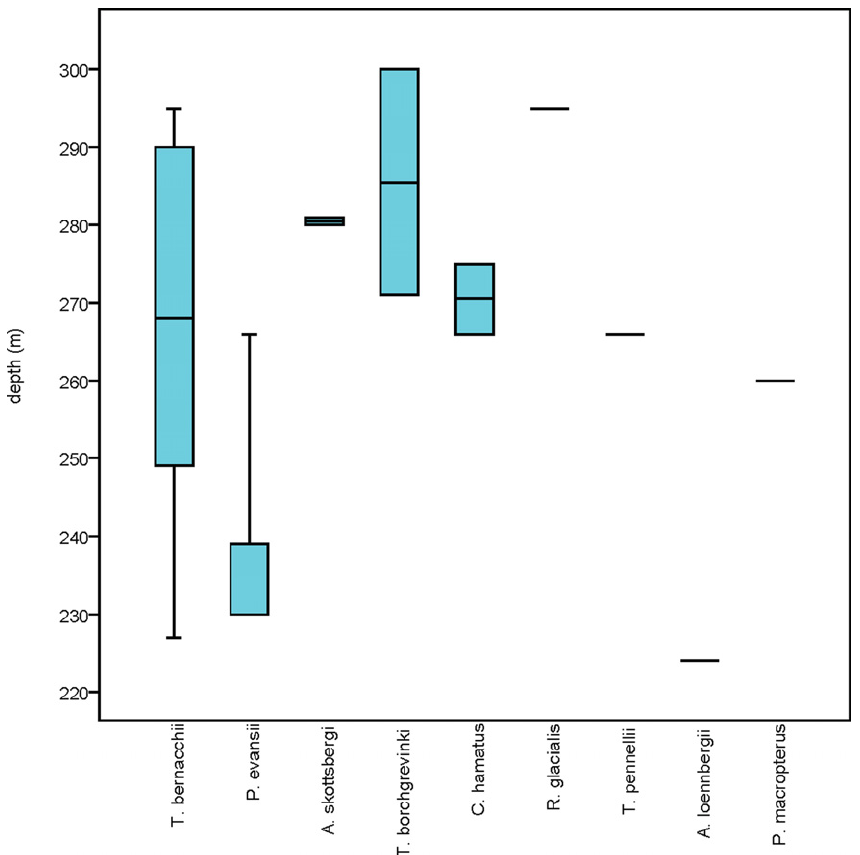
Figure 2. Box plot showing median, 25–75 percentiles, and maximum-minimum depth distribution of species along the transect Terra Nova Bay “Canyon” .